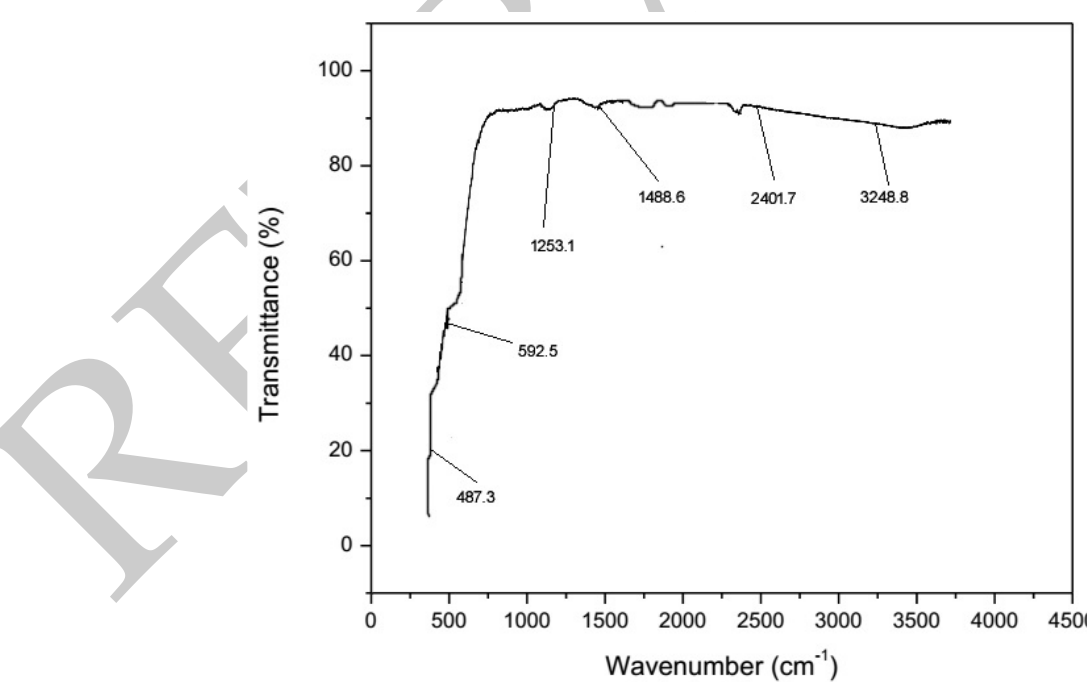
Figure 1. Fourier transform infrared (FTIR) analysis of the ZnFe 2 O 4 / TiO 2 photocatalyst performed on 4000–450 cm − 1 range spectrophotometer.